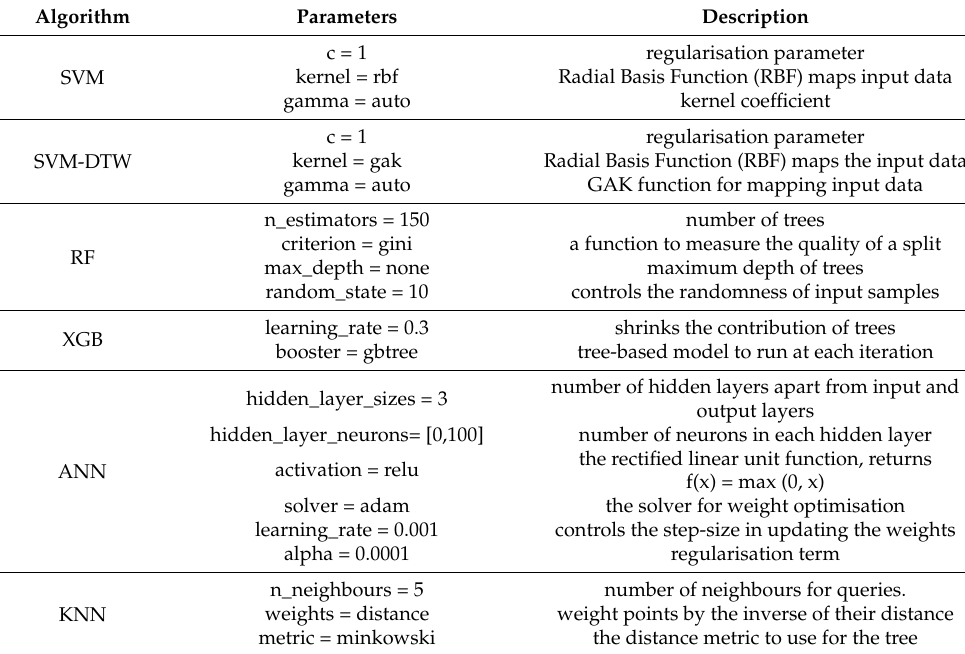
Table 3. Configuration parameters for classification algorithms.